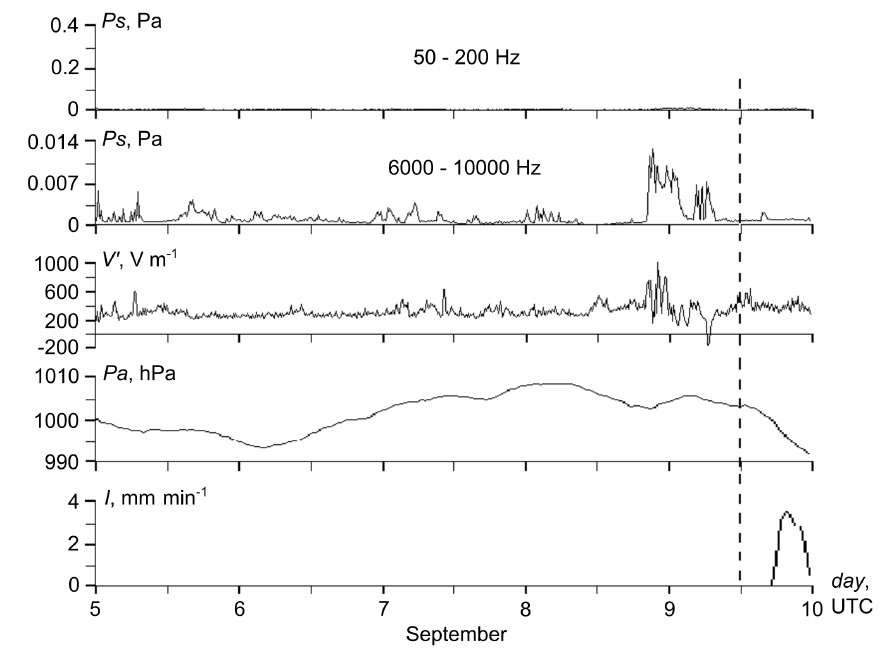
Figure 3. Joint anomalous disturbance of acoustic pressure P s in kilohertz frequency range and atmospheric electric field potential gradient V (cid:48) before the earthquake with the magnitude of 4.8 mb on 9 September 2005. Vertical dashed line indicates the